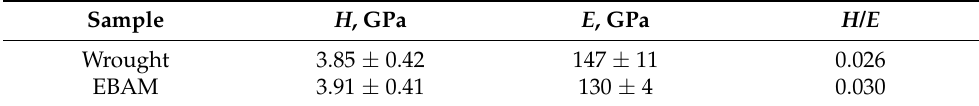
Table 4. Mechanical properties of the Ti-6Al-4V